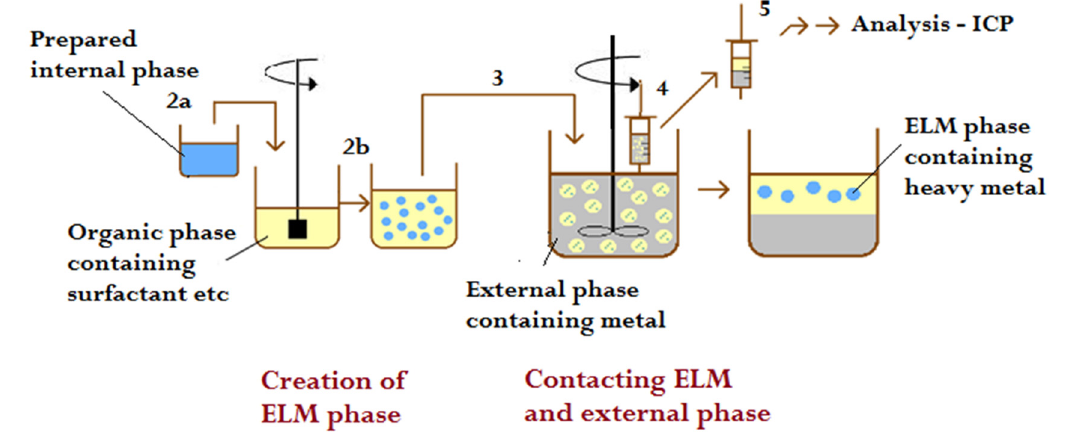
Figure 3. Schematic representation of the procedure of the metal extraction